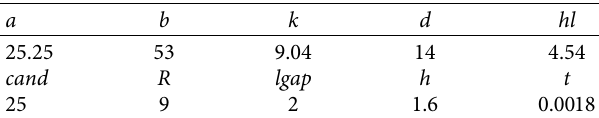
Table 2: Parameters of antenna 2